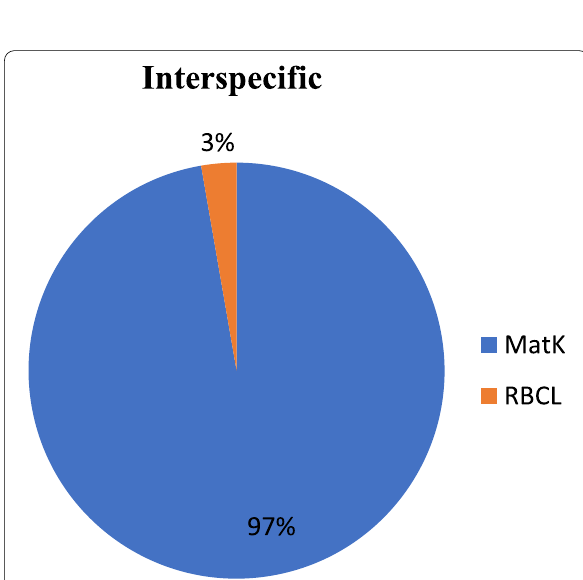
Fig. 8 Interspecific relationships between matK and rbcL gene of twelve accessions of S. tenuifolium and S. vaginatum collected from different locations